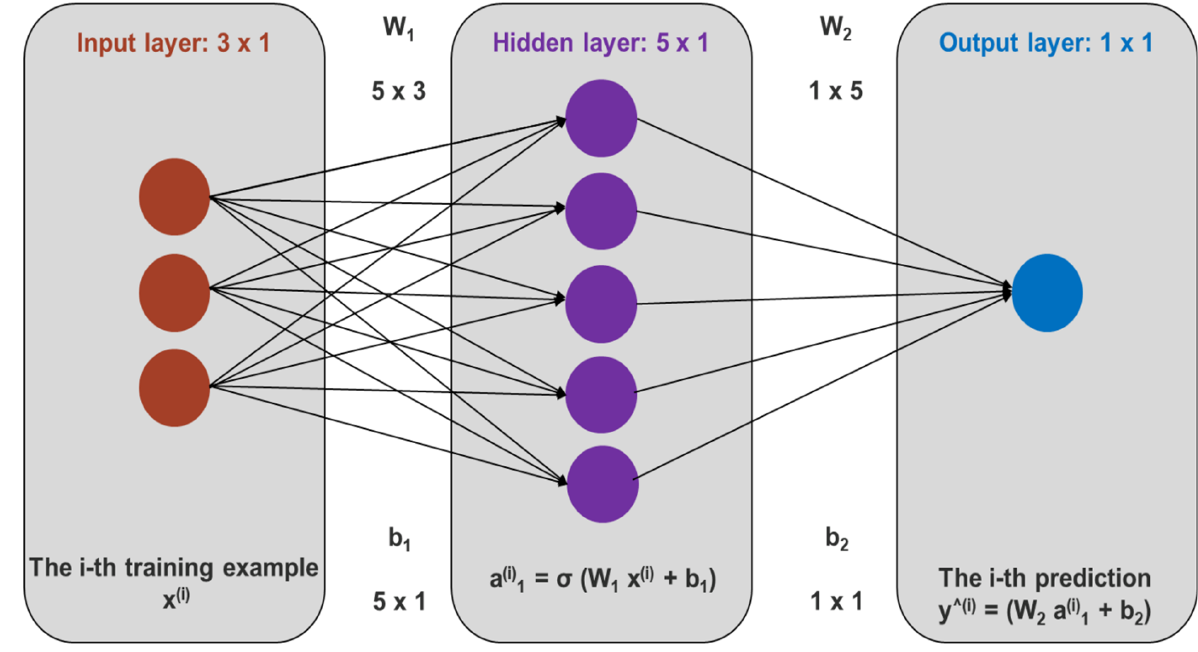
Figure A1. Schematic diagram of neural network architecture combining input layer, hidden layer, and output layer. In the figure x, y, W, b, and sigma are representing input vector, output vector, weighting vector, bias unit, and activation function respectively. Table A1. Description of final optimized hyperparameters for artificial neural network ensemble.